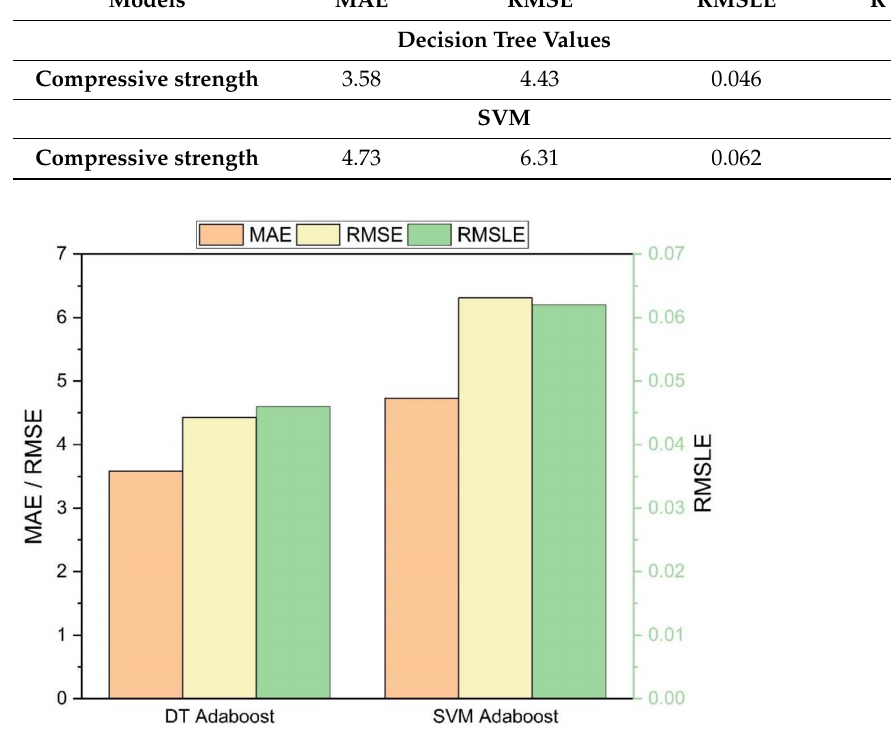
Figure 9. Comparison of errors for compressive